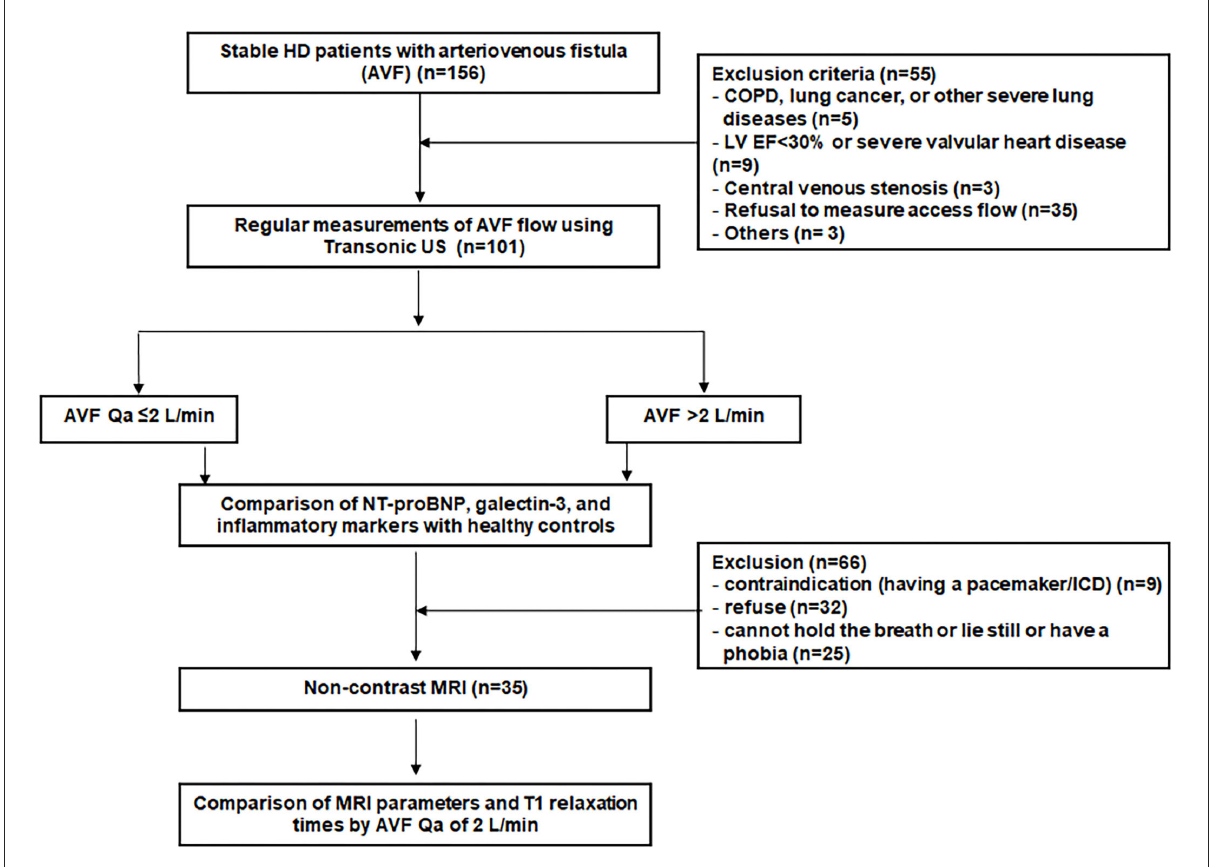
FIGURE1 Flow chart of the patient